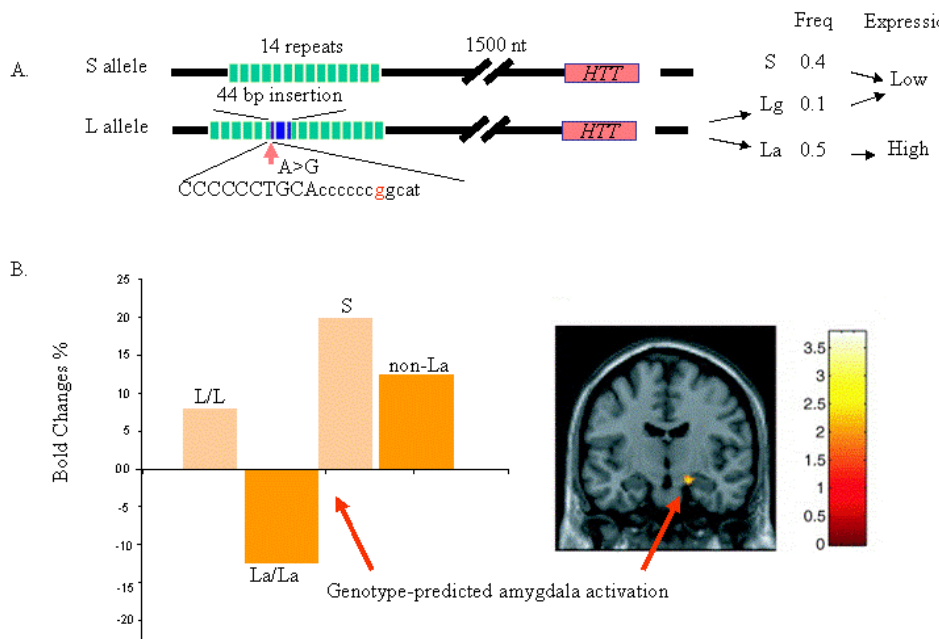
FIGURE 2. Serotonin transporter promoter polymorphism ( HTTLPR ) and relationship with amygdala activation during negative emotional stimuli. (A) A bi-allelic HTTLPR and a tri-allelic HTTLPR . Two forms of bi-allelic HTTLPR : long allele (L) and short allele (S). S allele decreases 5-HTT transcription and is associated with lower 5- HTT function. An additional A>G SNP is located on L allele of HTTLPR . L G decreases 5-HTT transcription similar to S allele. L A allele predicts greatest 5-HTT transcription and highest 5-HTT function. (B) Individuals with S allele increase amygdala activation, while individuals with L A allele have lowest activation in amygdala after negative emotional